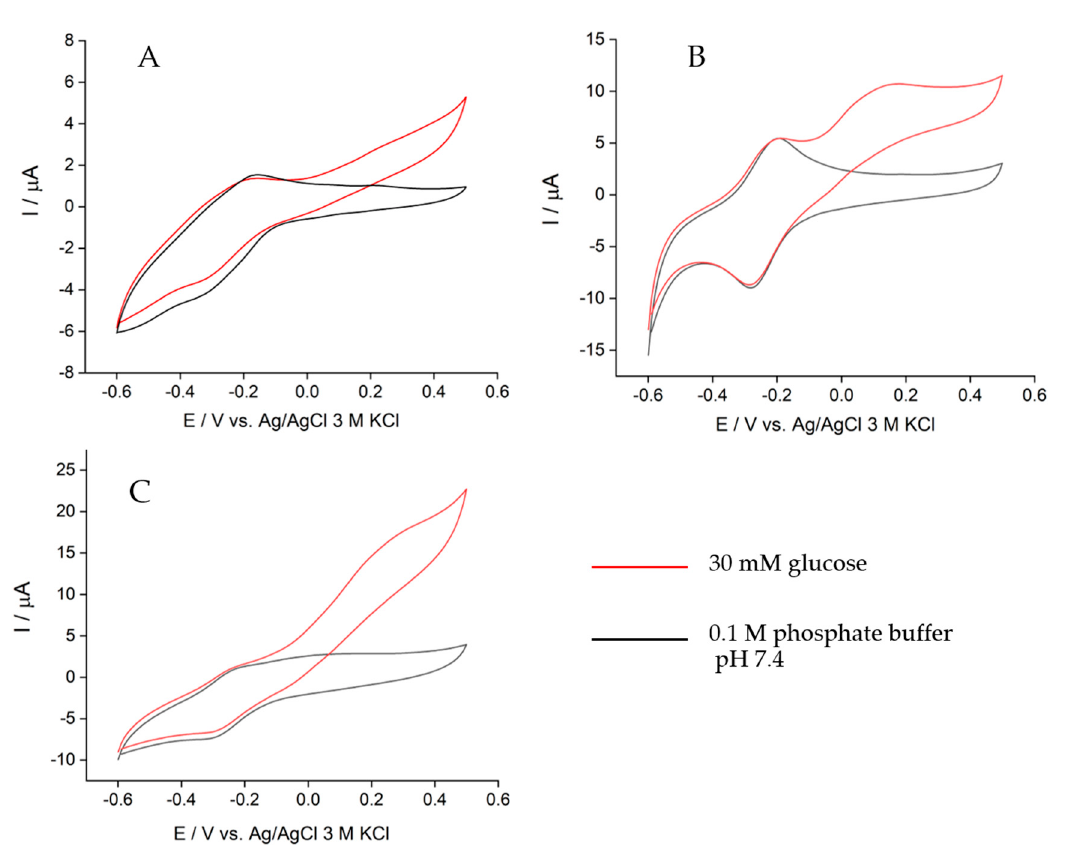
Figure 2. Cyclic voltammograms of the bioanode with different modifications: ( A ) GDH/poly(TBO)/GCE, ( B ) GDH/poly(TBO)/GO/GCE, and ( C ) GDH/poly(TBO)/rGO/GCE in the presence of 0.1 M phosphate buffer pH 7.4 containing 5 mM NAD + and 30 mM glucose (red) and the absence of glucose (black) at a scan rate of 10 mV/s, air-saturating conditions.